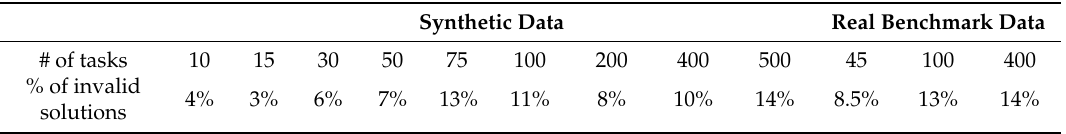
Table 5. Percentage of invalid solutions.